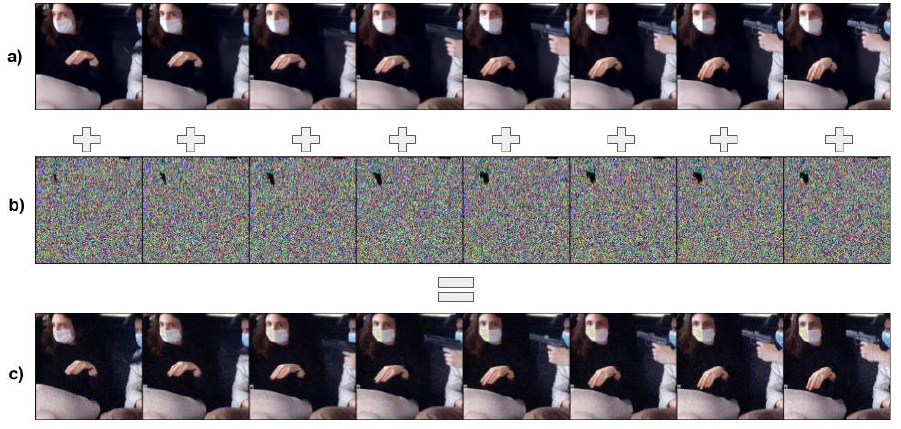
Figure 3. Video level adversarial attack. In this figure, we show how we can obtain the video level adversarial attack. ( a ) Shows a sequence of the input frames, ( b ) presents the adversarial noise obtained from the FGSM, and ( c ) shows the complete video adversarial attack resultant after add adversarial noise on each input